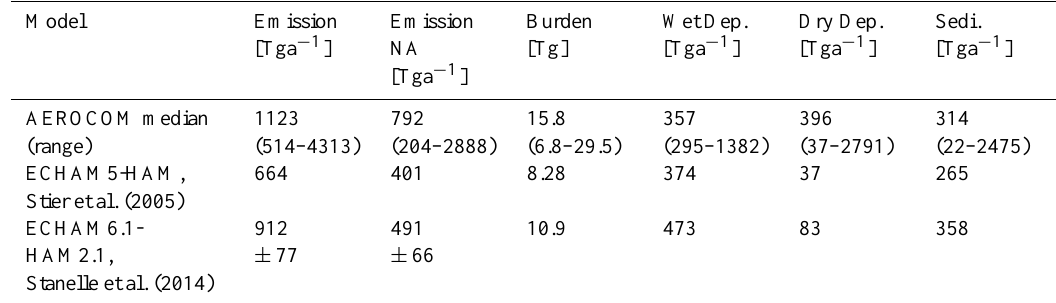
Table 1. Global dust emission, burden and deposition, and e mission in North Africa (NA) from the AEROCOM models (Huneeus et al., 2011) including ECHAM5-HAM for the year 2000 and from ECHAM6.1-HAM2.1 averaged for 2000–2009. Uncertainties in the last two rows are standard deviations of the 10-year ensemble.